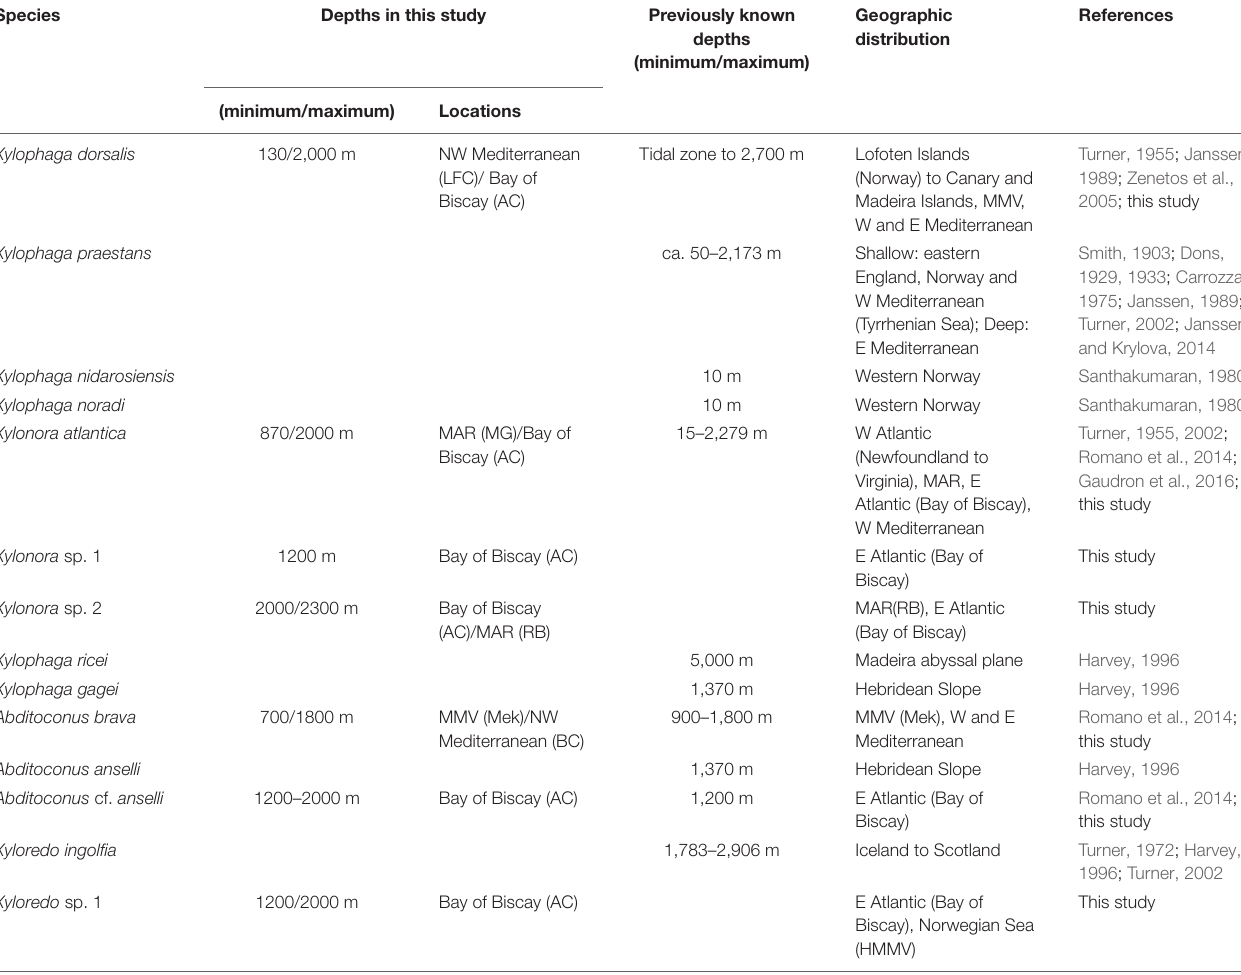
TABLE 4 | Depth distributions (minimum/maximum) of the xylophagaid species recorded in the North East Atlantic and adjacent marginal seas.